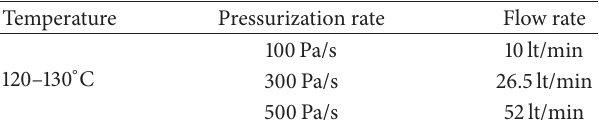
Table 1: Flow rate